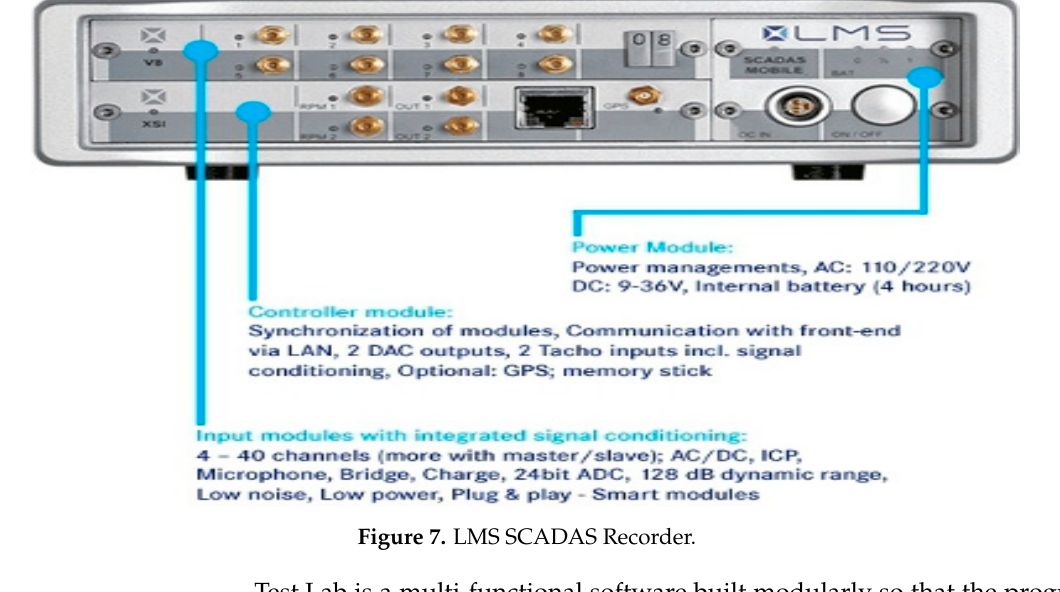
Figure 7. LMS SCADAS Recorder.